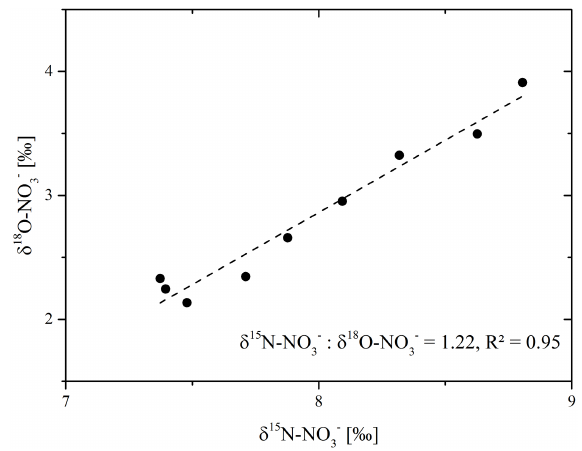
Figure 3. Ratio of δ 18 O–NO − vs. δ 15 N–NO − values correspond- 3 3 ing to decreasing nitrate concentrations from 13 to 20 June and filled data points of Fig. 1b and c. The calculated linear regression has a slope of 1.22 with R 2 of 0.95.